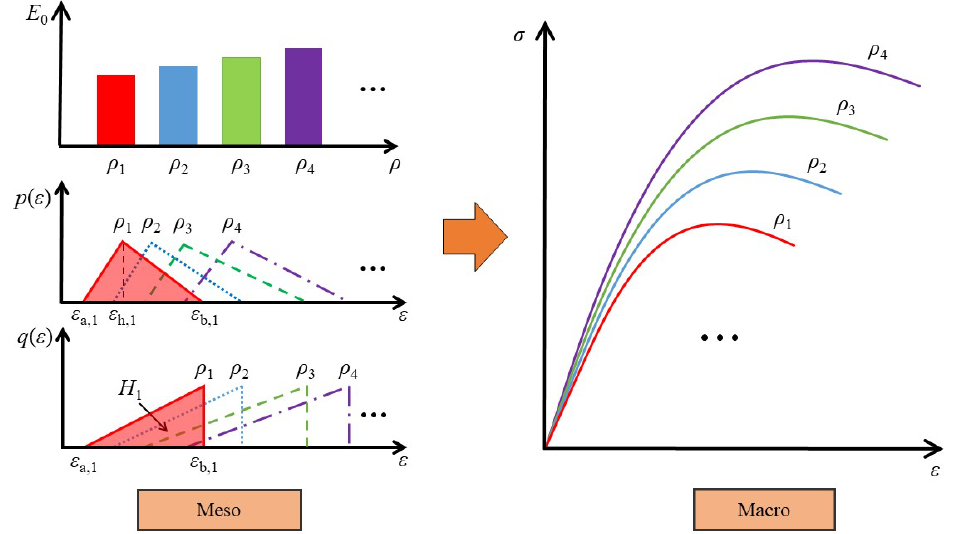
Figure 6. The influence of the fiber volume fraction on the damage mechanism of